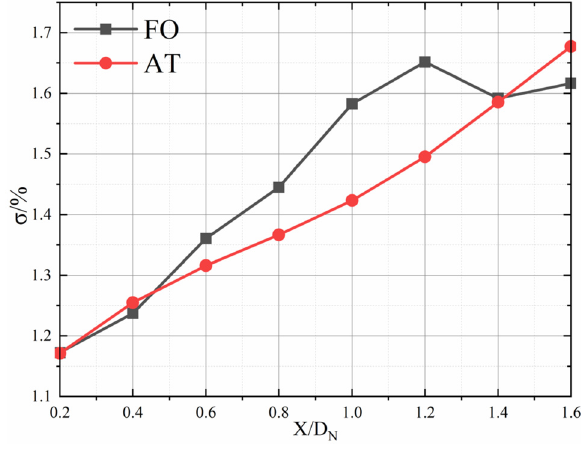
Figure 11. Total pressure loss of equal mass flow cross-sectional area for total pressure 140 kPa.